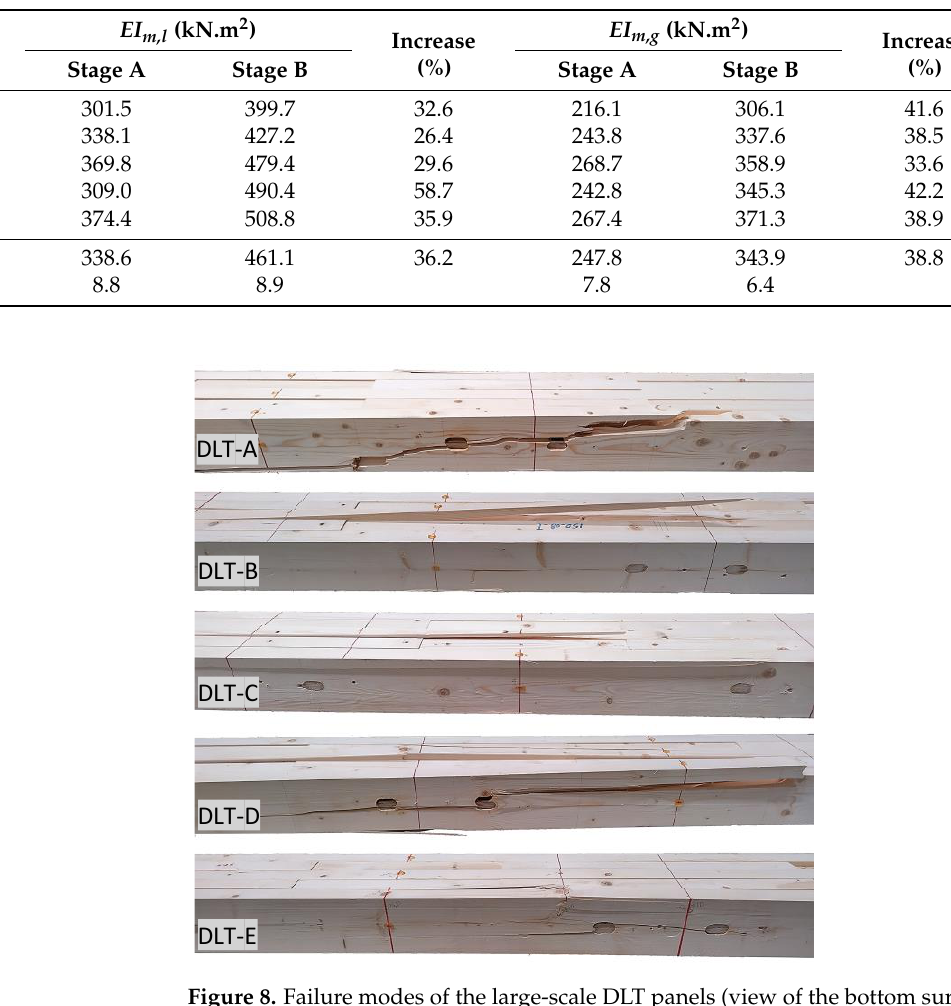
Figure 8. Failure modes of the large-scale DLT panels (view of the bottom surface of the panels).